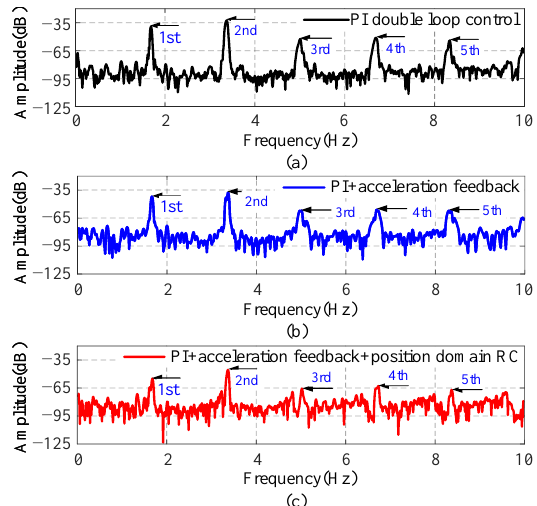
Figure 12. Experimental results of the steady-state response in time domain speed: ( a ) PI double loop control; ( b ) PI+acceleration feedback; ( c ) PI+acceleration feedback+position domain RC.